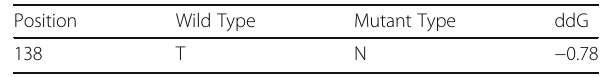
Table 3 Output results of the STRUM program. The change in stability scores between the mutant and wild type RS1